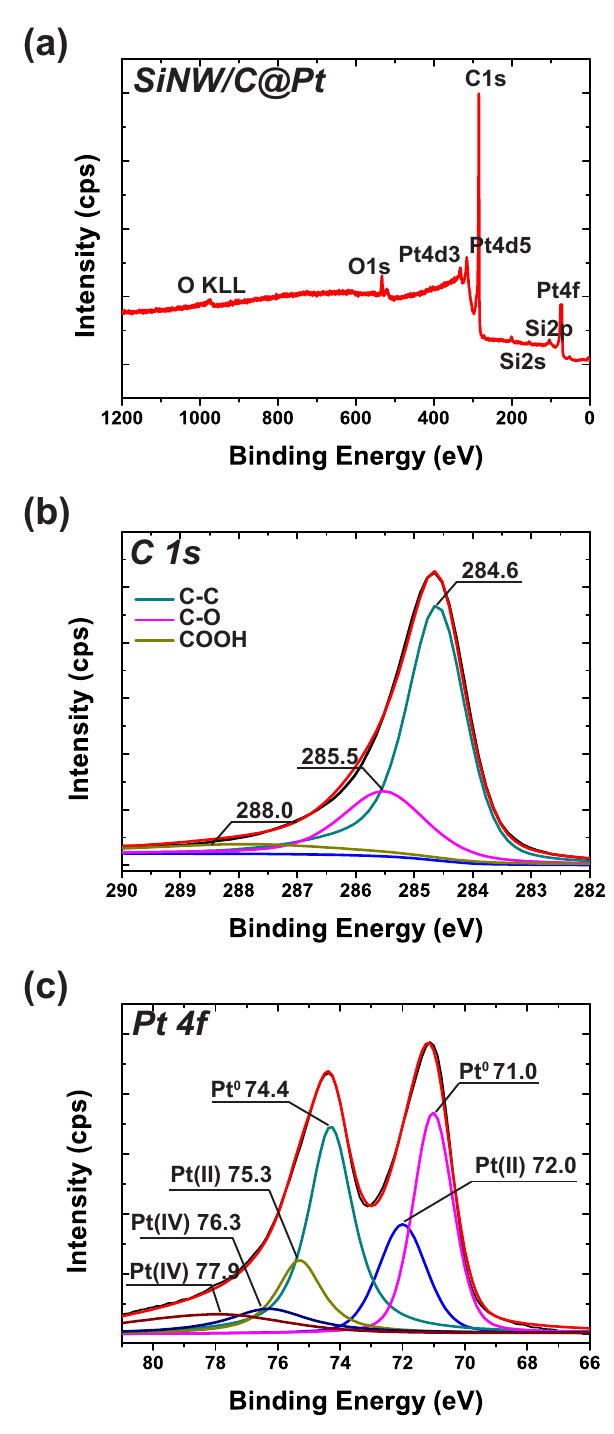
Figure 4. X-ray photoelectron spectroscopy analysis of SiNW/C@Pt: ( a ) survey scan; ( b ) high-resolution spectrum of C 1s; and ( c ) high-resolution spectrum of Pt